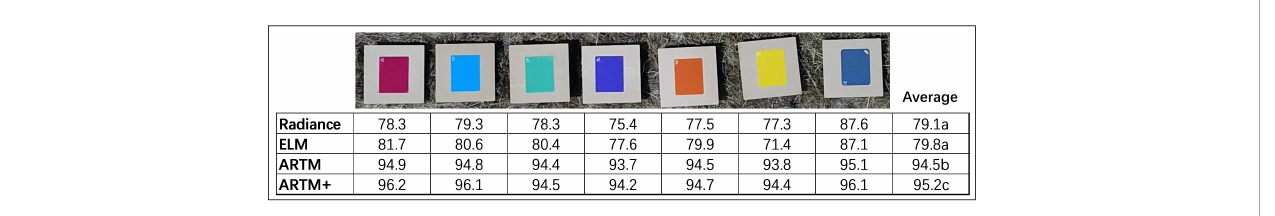
FIGURE 4 Classi fi cation functions derived from optical remote sensing data acquired from colored panels during one fl ight mission (Day 2, 12:12) were used to develop classi fi cation functions for each of the four levels of spectral calibration. Subsequently, these classi fi cation functions were applied to hyperspectral remote sensing data acquired during each of the 52 fl ight missions. Numbers of correctly classi fi ed pixels were used as proxy to estimate spectral repeatability for each color panel. Letters indicate statistical difference at the